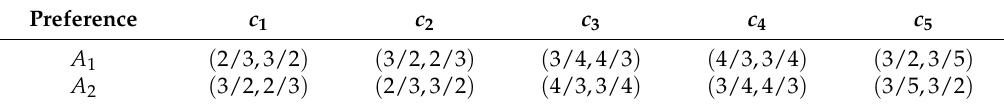
Table 2. The indifference relation between A 1 and A 2 if n is